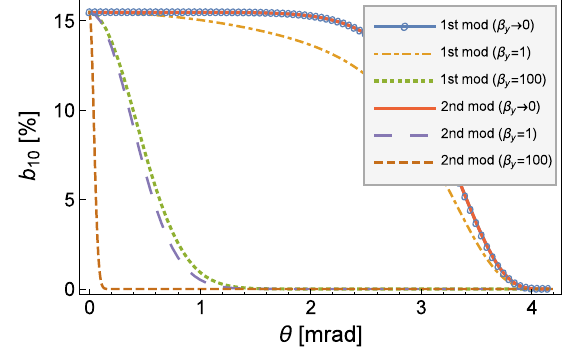
FIG. 6. In the EEHG mechanism, the bunching factor at 10th harmonic b 10 as a function of the laser incident angle θ with different beta functions. “ 1st mod ” refers to the laser angular drift occurring only in the first modulator. So does “ 2nd mod ”